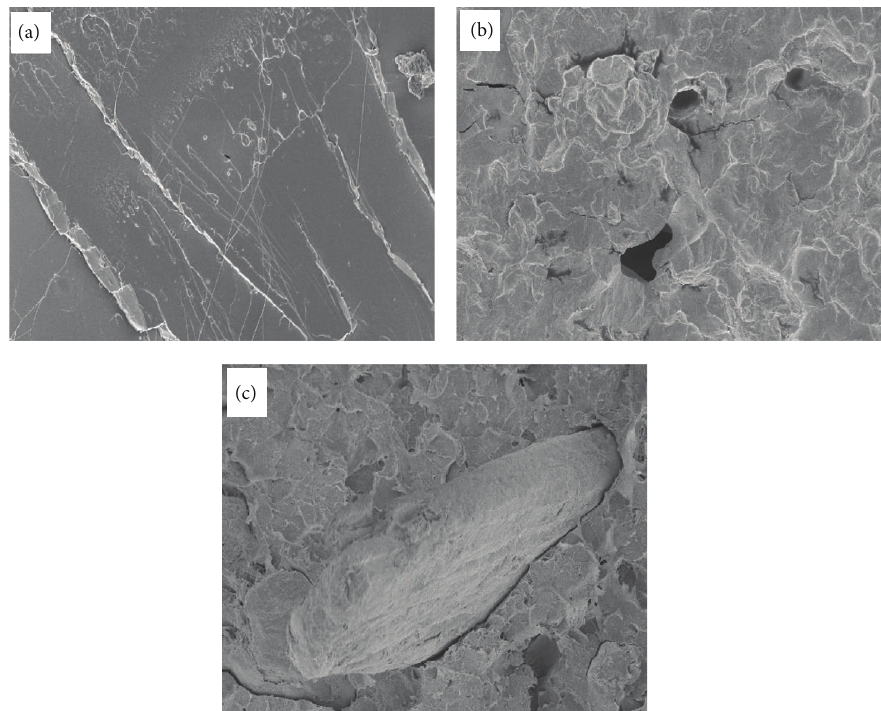
Figure 10: FESEM micrographs of flexural fractured surfaces of (a) pure PLA, (b) PLA/AT RHF, and (c) PLA/WT RHF composites [48].